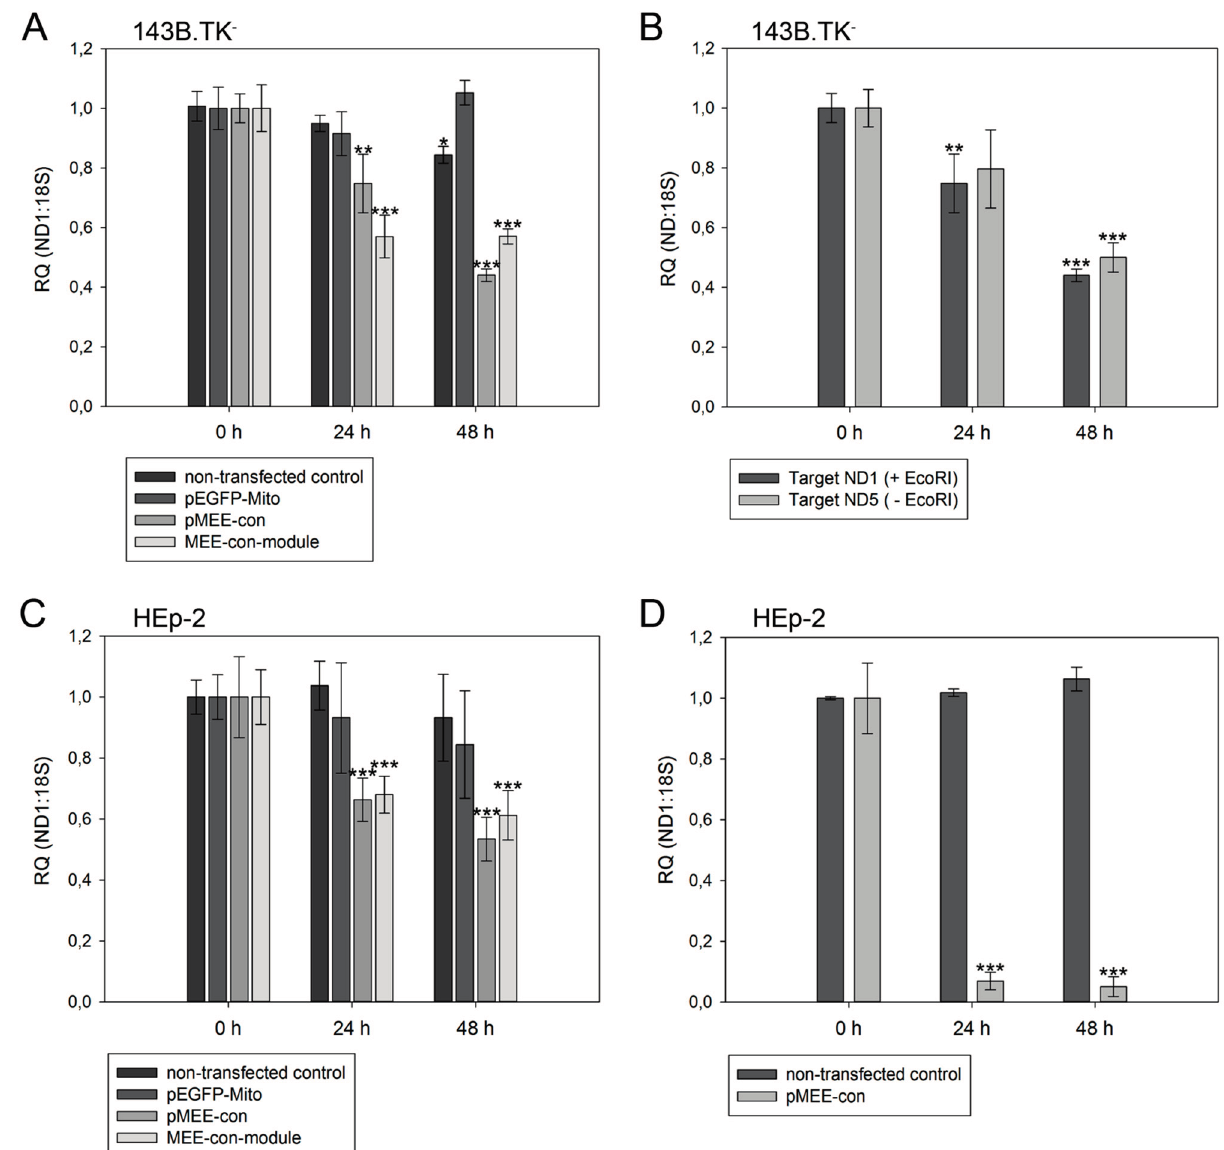
Figure 5. Relative quantification of mtDNA in transfected cells. Cells were harvested directly before (0 h) or 24 h/48 h post-transfection with pEGFP-Mito (transfection control), circular depletion system (pMEE-con) or linear depletion system (MEE-con-module). triplicate. Data are expressed as ratio between mitochondrial DNA ( ND1 or ND5 gene) vs. nuclear (ribosomal 18S gene) DNA content. Bars represent the mean ± SD. * p < 0.05, ** p < 0.01, *** p < 0.001. ( A ) 143B.TK − cells; ( B ) 143B.TK − cells transfected with ND1 (04094–04175 bp) and ND5 (13,893–13,983 bp) gene as targets in real-time